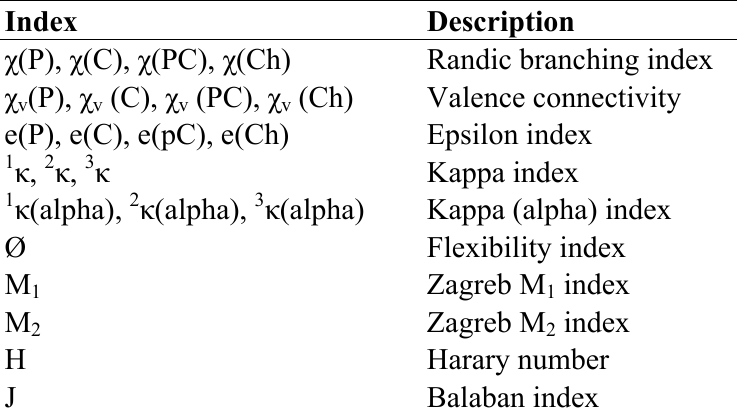
Table 1. Topological Indices used in the present